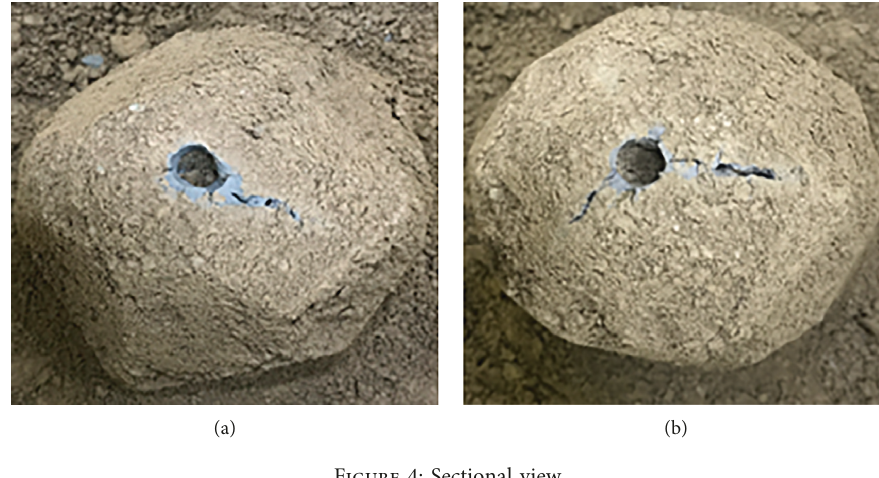
Figure 4: Sectional view.